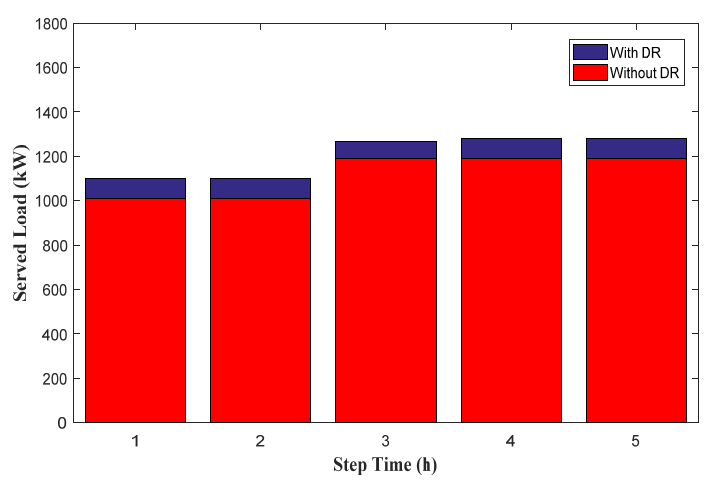
Figure 13. The effect of the EDRP on the outage cost in the 66 bus case.